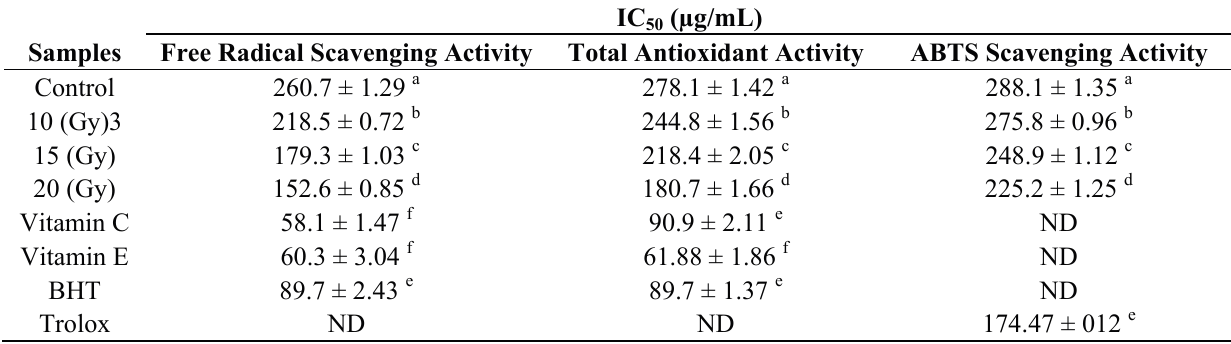
Table 5. The IC values of extracts and standards in DPPH, FRAP and ABTS scavenging 50 activities (Mean ± SEM; n =